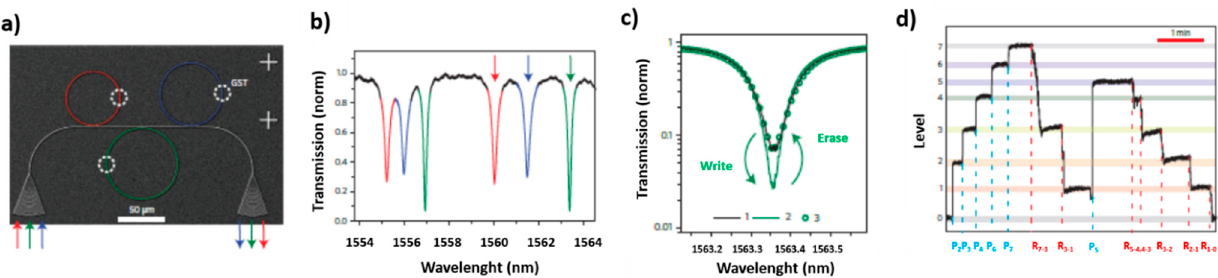
Figure 15. ( a ) SEM image of the architecture of the system used by Rios et al. as a memory device, composed of three differently-sized ring resonators containing a switchable GST225 unit, combined with a feeding waveguide; ( b ) measured transmission at the through port: a group of three distinct resonances, corresponding to the respectively colored rings, are observed; ( c ) variation of transmission at the through port upon GST225 switching, for one individual element. Writing is obtained through amorphization, erasing is obtained through crystallization; ( d ) multilevel operation: 7 different levels can be reached inside the device, by applying laser pulses P i characterized by different power ( E P1 = 372 ± 12 pJ, E P2 = 415 ± 13 pJ, E P3 =465 ± 13 pJ, E P4 = 524 ± 14 pJ, E P5 = 561 ± 14 pJ, E P6 = 585 ± 14 pJ and E P7 = 601 ± 15 pJ). Each level is accessible in consecutive (both ascending or descending) or arbitrary order. R n − m indicates a partial erasing process. Reproduced from Ref. [111] with permission from Nature Springer.